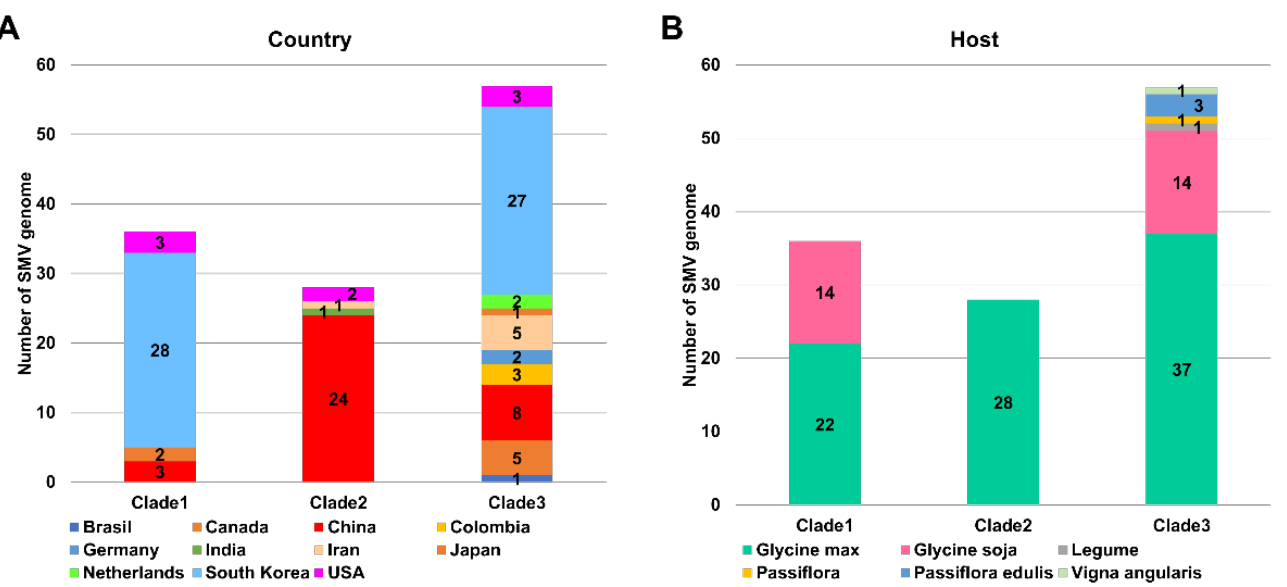
Figure 3. Composition of SMV isolates in the three major clades that became apparent when the isolates were analyzed based on their country of origin and host plant. The number of SMV isolates in each of the three major clades (clades 1 through 3) based on country of origin ( A ) and host plant ( B ) are indicated.